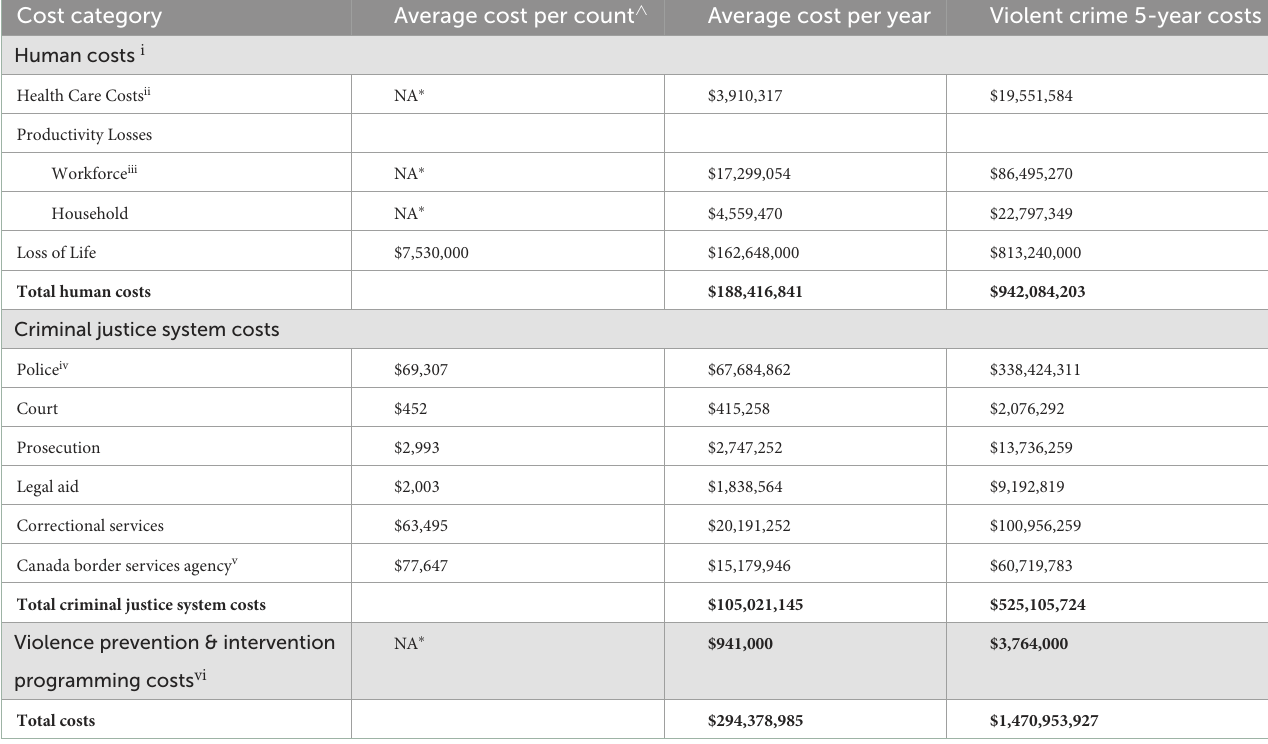
TABLE 4 Overall average and total costs for firearm violent crime in 2016 CAN Dollars, B.C.